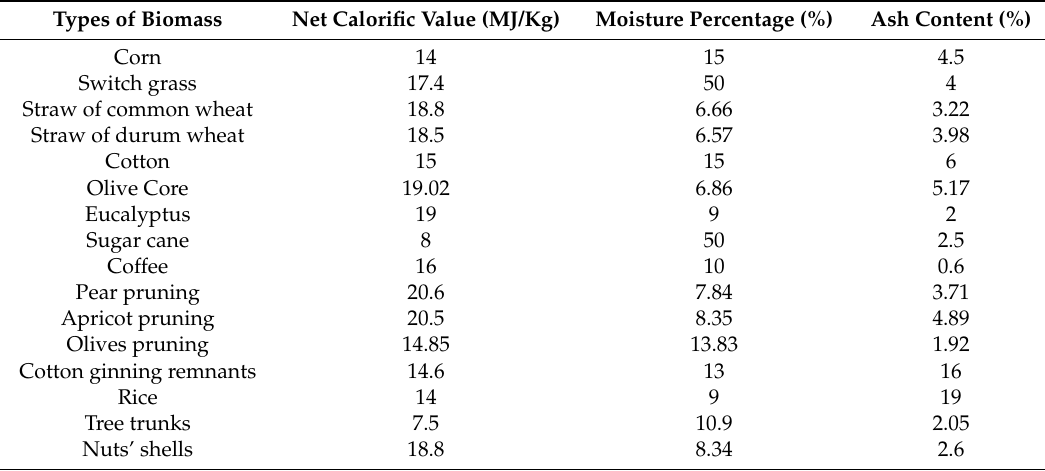
Table 1. Mean values of qualitative characteristics of known biomass sources (calorific value, humidity, ash)